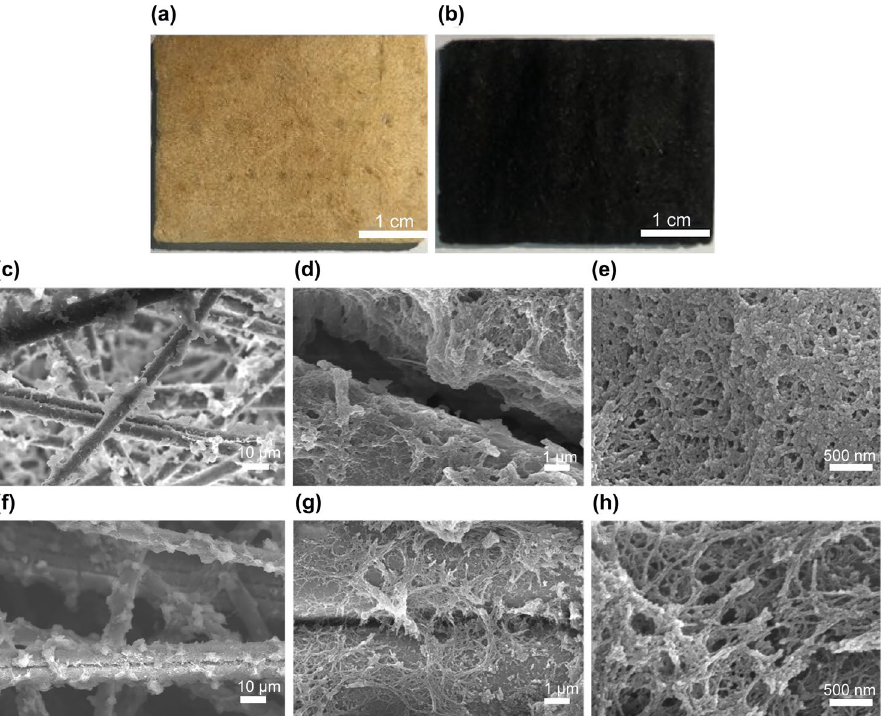
Figure 6. Digital images ( a ) before and ( b ) after pyrolysis and typical scanning electron microscopy (SEM) micrographs of ceramic aerogel composite ( c – e ) before and ( g – h ) after pyrolysis at 1000 °C.